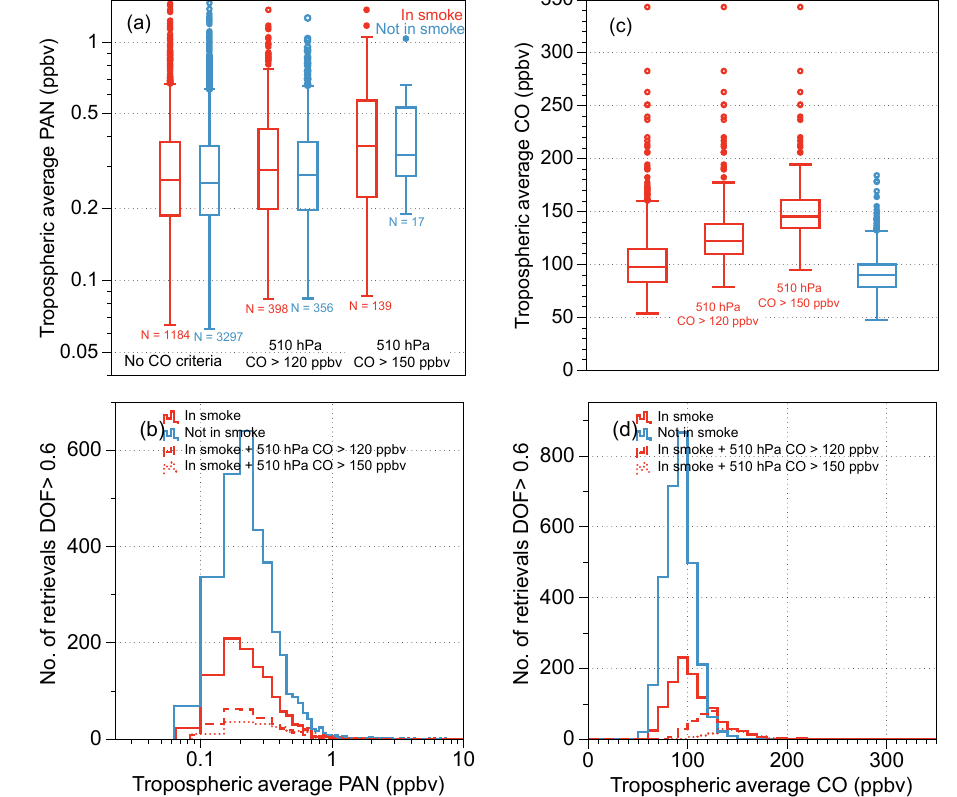
Figure 5. (a) Box plots of July 2006–2009 North American TES PAN retrievals colored by whether they overlap HMS smoke plume polygons. Red (“In Smoke”) designates overlap; blue-grey designates non-overlapping retrievals. The left set of box plots include all the retrievals with DOF>0.6, the center set of box plots only include retrievals with 510hPa TES CO>120ppbv, and the right set of box plots only include retrievals with 510hPa TES CO>150ppbv. (b) Histograms of July 2006–2009 TES PAN retrievals. (c) Box plots of July 2006– 2009 TES CO retrievals coincident with the TES PAN retrievals subset by 510hPa TES CO. (d) Histograms of July 2006–2009 TES CO retrievals coincident with the TES PAN retrievals. The box plots display the interquartile range for each subset and the dots represent